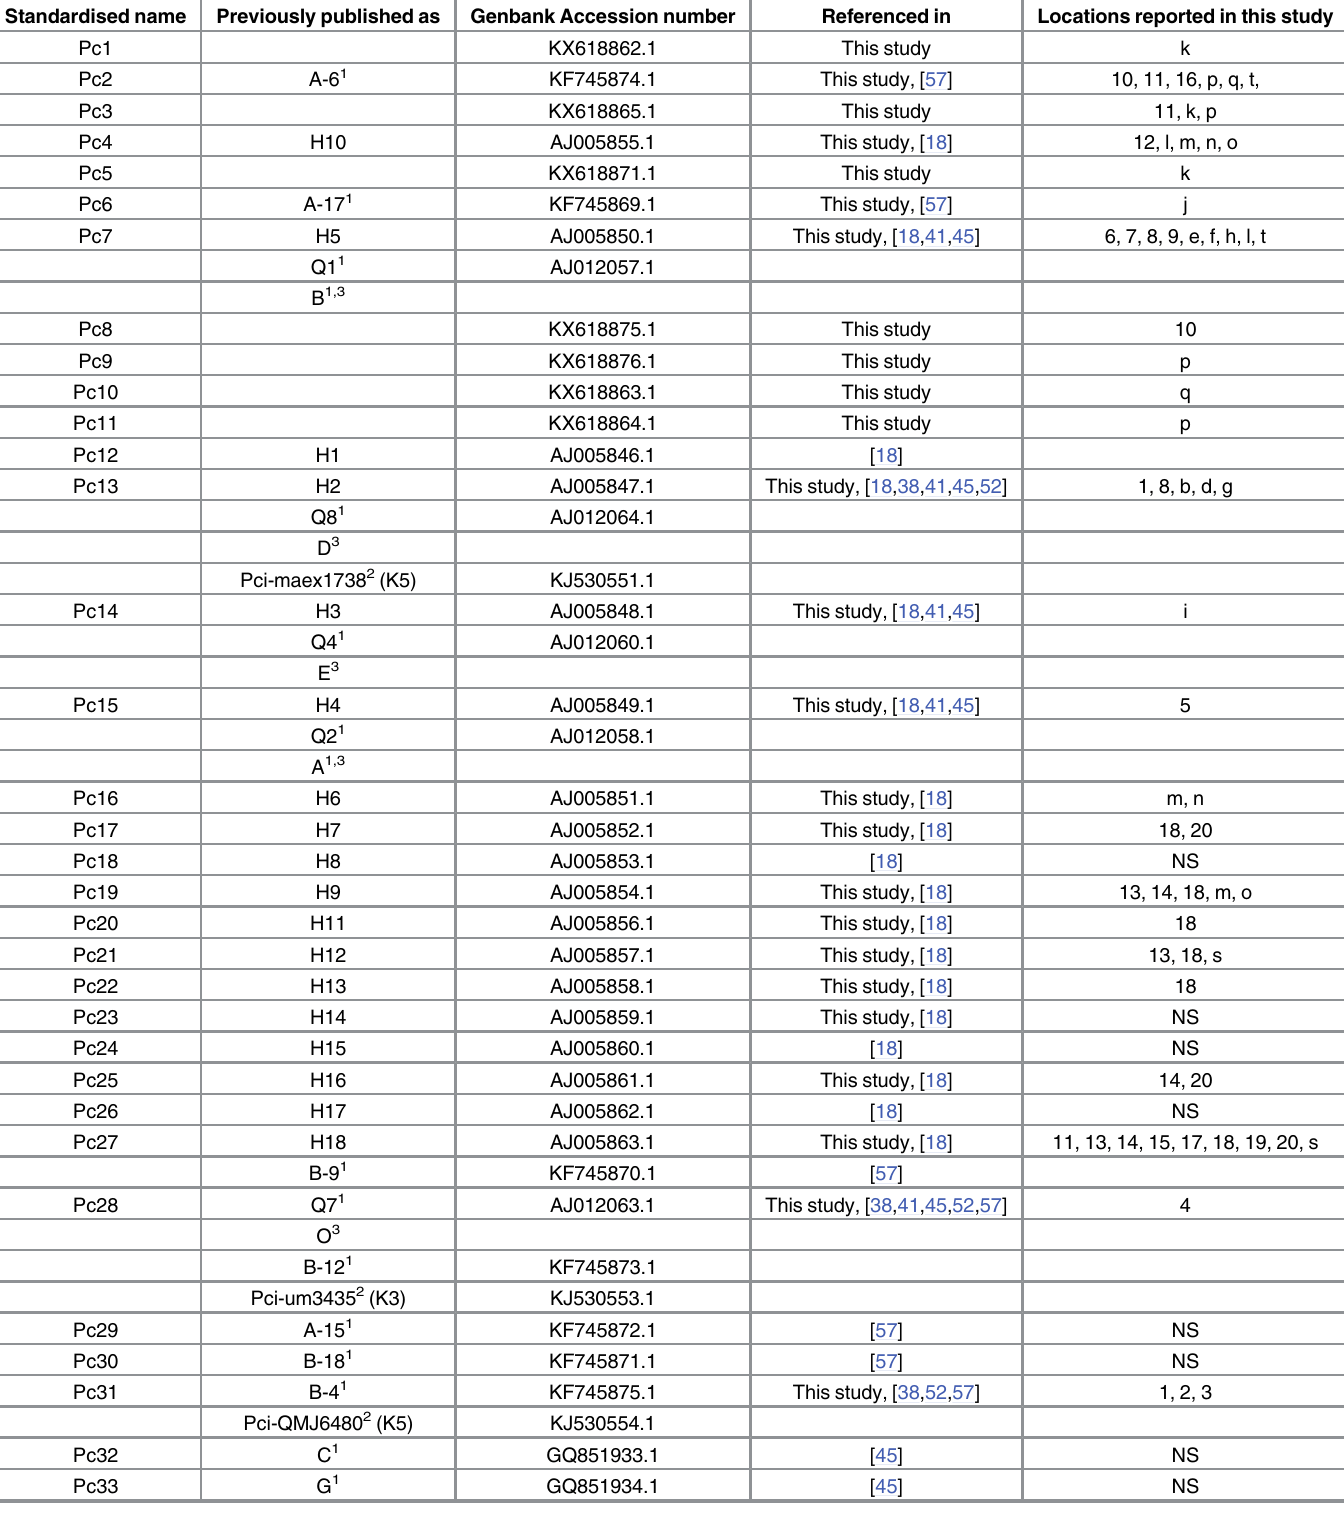
Table 2. List of the 53 unique mitochondrial DNA Control Region haplotypes found in